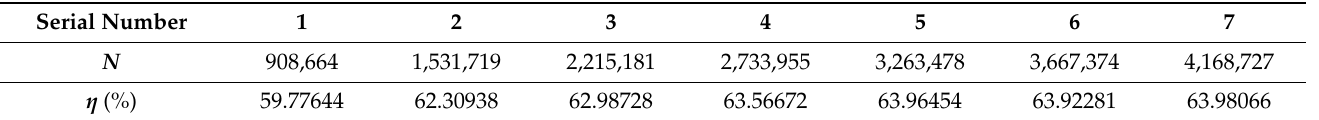
Table 1. Grid irrelevance analysis table.